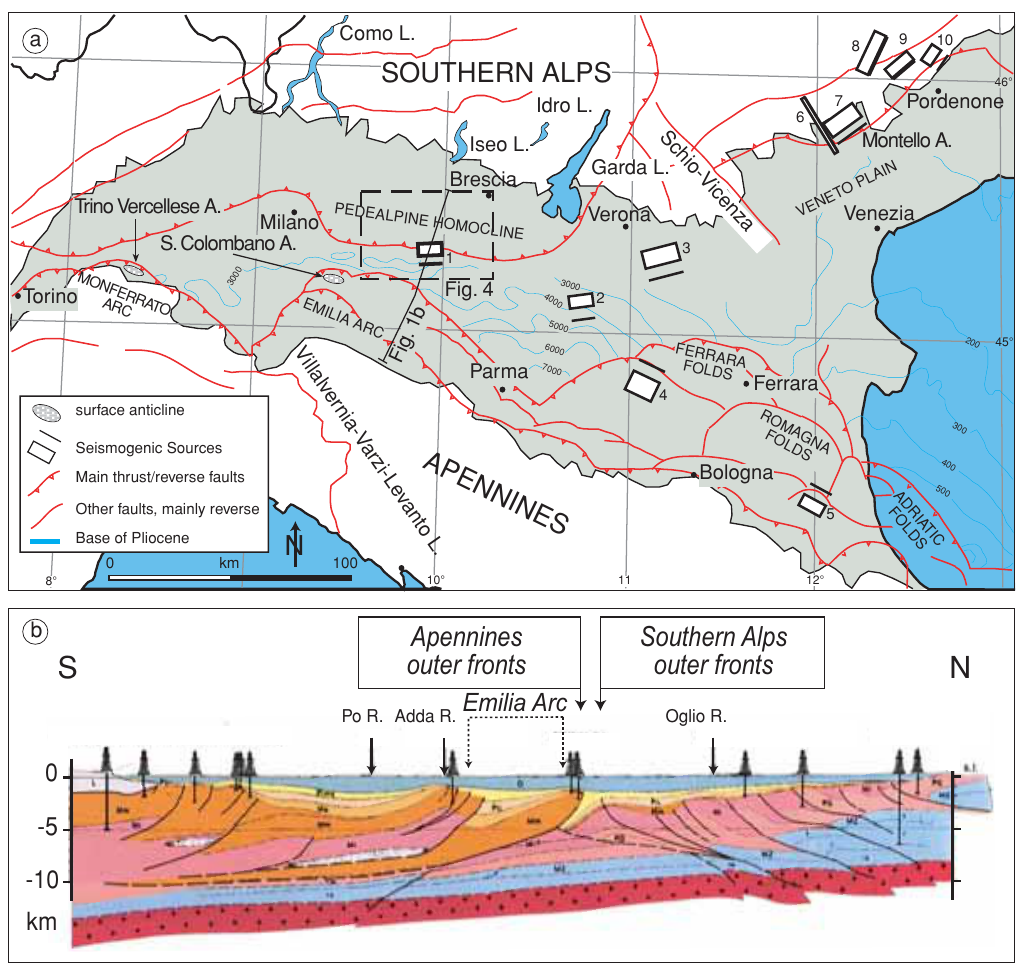
Fig. 1a,b. a) Simplified structural map of the Po Plain and neighbouring Veneto Plain, showing the main tecton- ic elements (from Pieri and Groppi, 1981, modified), and contours of the base of the Plio-Quaternary sedimentary sequence (from Bigi et al. , 1989). The plain is shaded in light grey, while higher topography regions are shown in white. The outer thrust fronts of the Southern Alps and of the Apennines are buried beneath the thick syn-orogenic clastic deposits. The seismogenic sources are from Valensise and Pantosti (2001b) and are identified in table II. b) Structural cross-section of the Central Po Plain, showing the main buried thrust fronts of the Northern Apen- nines and Southern Alps (from Cassano et al. , 1986, modified). Location of the trace is shown in fig.